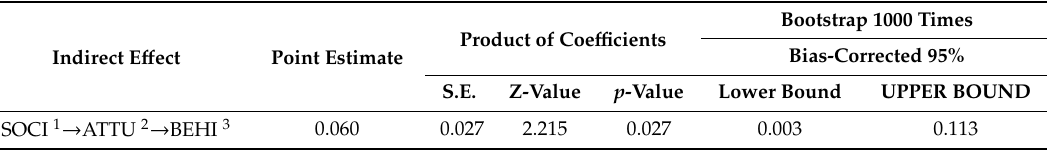
Table 8. Indirect e ff ect